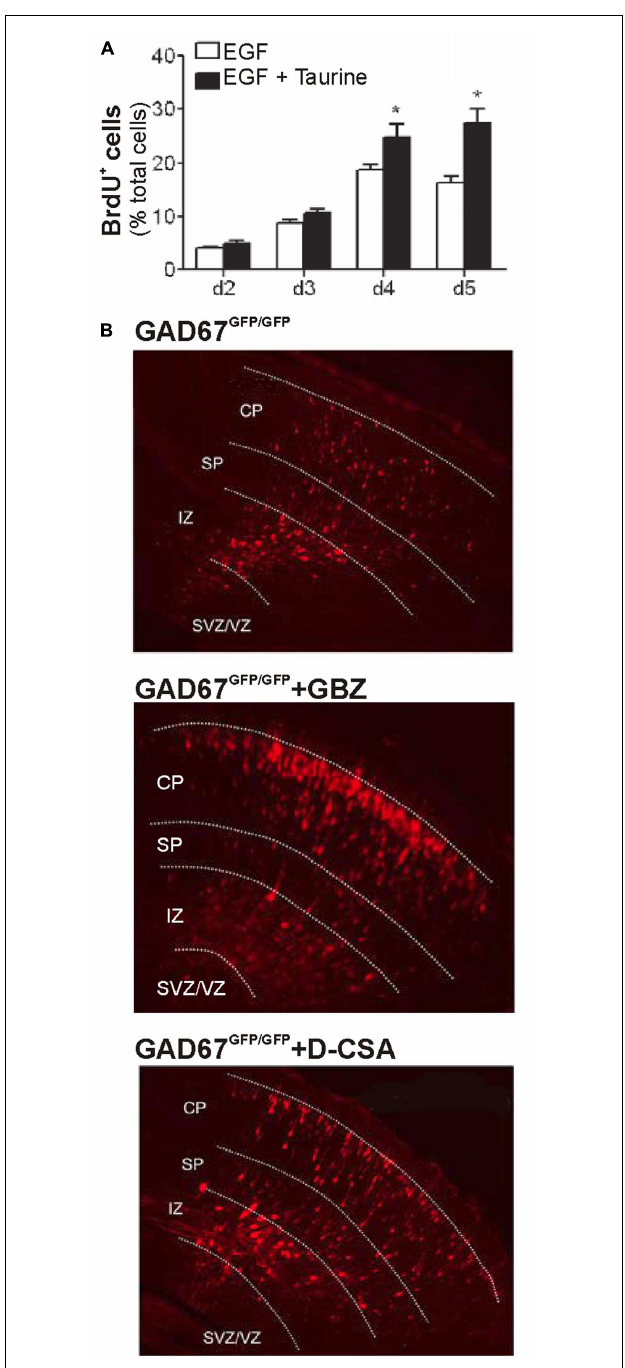
FIGURE 3 | Effect of taurine on proliferation and migration. (A) Taurine (10 mM) enhances the fraction of BrdU positive neurons in mouse neurospheres after 4–5 days in culture, indicating that taurine promotes proliferation ( ∗ indicate P < 0.05, with permission from Hernandez-Benitez et al., 2010). (B) Radial migration of RFP-labeled neurons in the substantially GABA-depleted GAD67-GFP mice can be enhanced by inhibition of GABA A receptors with gabazine (middle image) and by inhibition of maternal taurine synthesis with D-cysteinate (D-CSA, lower image), indicating that taurine acting of GABA A receptors modulate radial migration in vivo (modified with permission from Furukawa et al.,